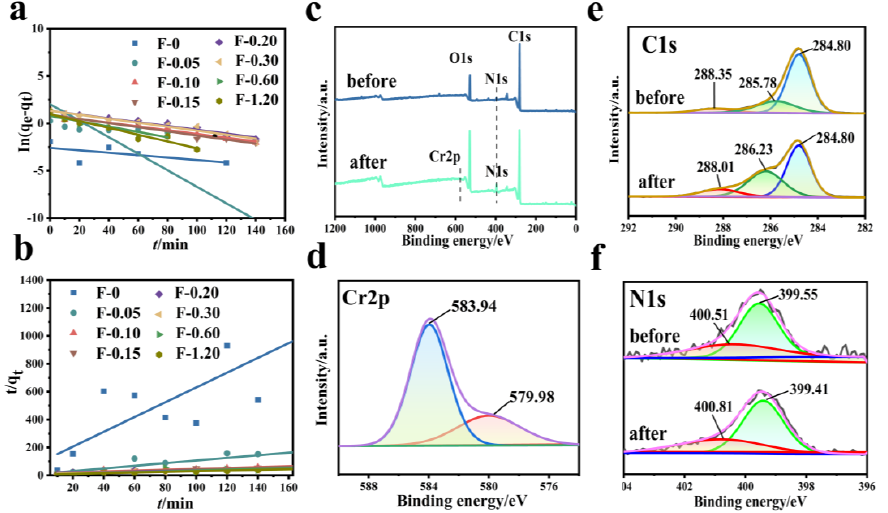
Figure 9. ( a ) First-order kinetic simulation of Cr (VI) adsorption by the composite membrane. Reaction conditions: Cr (VI) (20 mg/L, 60 mL), composite membrane (0.2 g). ( b ) Second-order kinetic